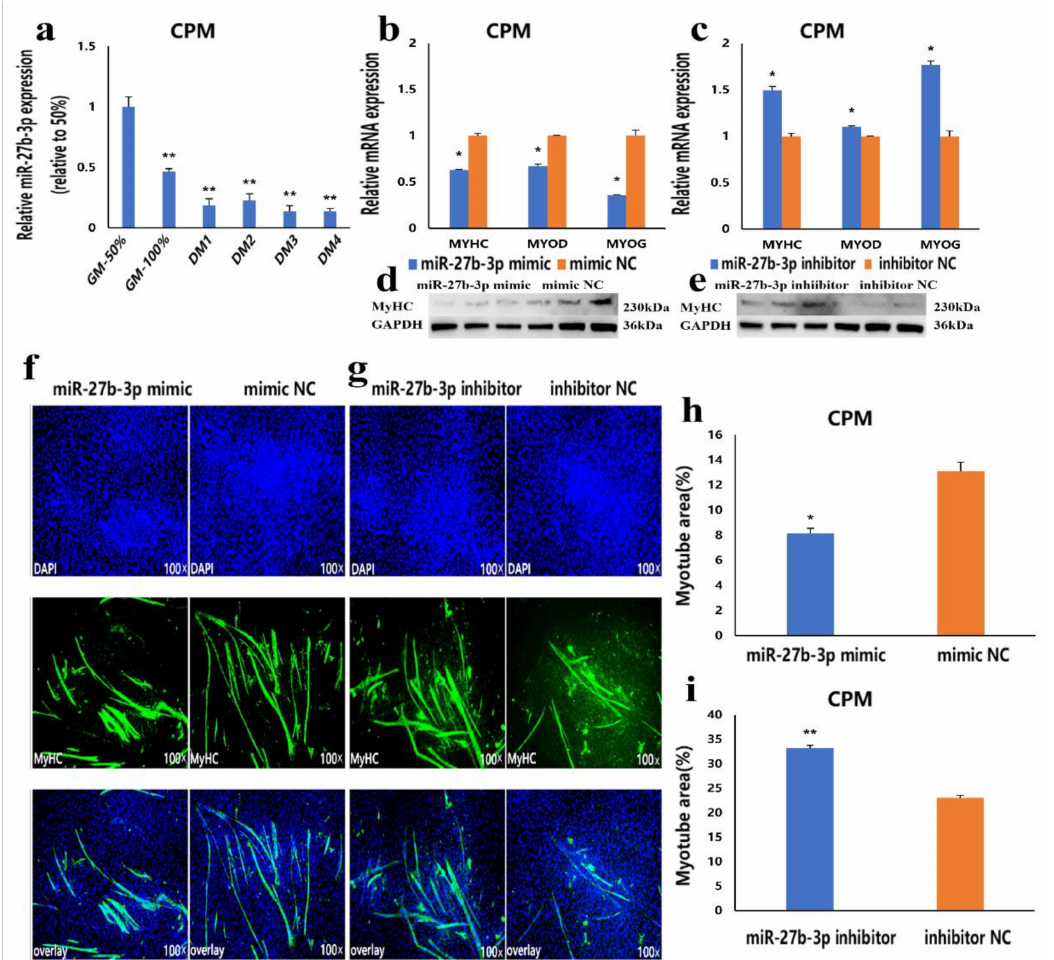
Figure 3. CPMs’ differentiation is inhibited by miR-27b-3p. ( a ) The relative expression of miR-27b-3p during CPMs’ proliferation and differentiation (GM 50% and GM 100% represent the proliferation density of 50% and 100%; DM1-DM 4 represents differentiation from one to four days). ( b , c ) The mRNA expression levels of three differentiation marker genes after transfection with miR-27b-3p mimic and inhibitor in CPMs. ( d , e ) The protein expression level of MyHC after transfection with miR-27b-3p mimic and inhibitor in CPMs. ( f , g ) MyHC staining of CPMs at 72 h after transfection with miR-27b-3p mimic and inhibitor in CPMs. Microscopic images were obtained by a fluorescence inverted microscope (dmi8, Leica, Germany). ( h , i ) Myotube area (%) of CPMs 72 h after overexpression and inhibition of miR-27b-3p. In all graphs, the results are shown as mean ± SEM (standard error of the mean) (n = 3). Statistical significance of differences between means was assessed, using the unpaired Student’s t -test (* p < 0.05; ** p < 0.01) vs. NC (negative